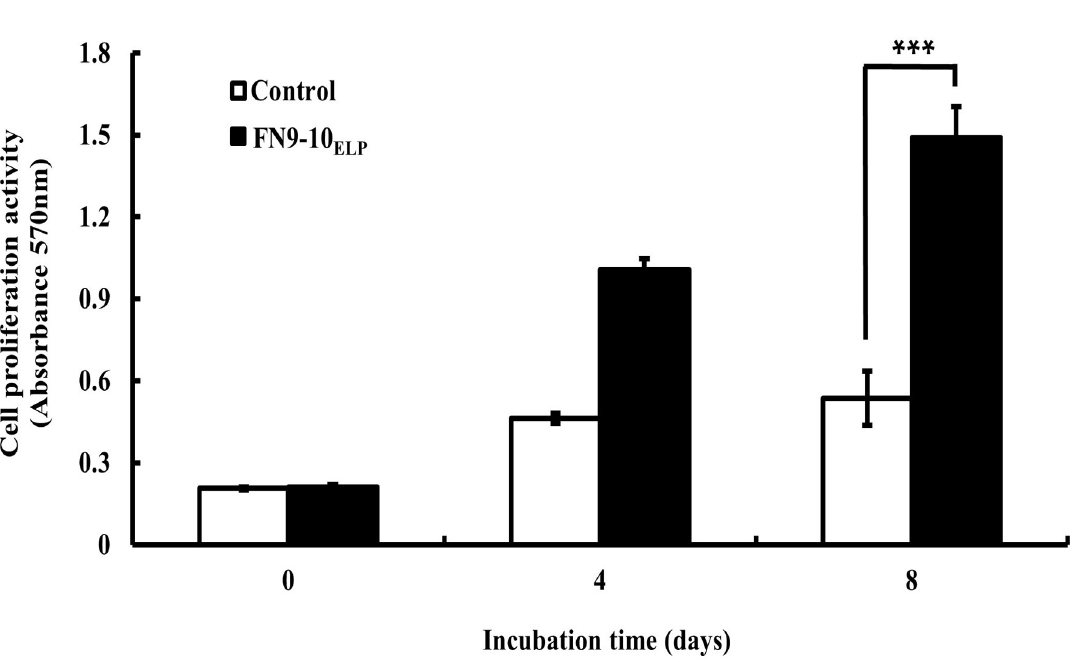
Fig 5. Cell proliferation activity of hMSCs on the FN9-10 ELP -titanium discs for 0, 4 and 8 days. The titanium discs were immersed in 0 or 10 μ g � mL − 1 FN9-10 ELP overnight at 4˚C then, hMSCs were seeded at a density of 1 × 10 4 cells/disc on titanium discs and incubated for 0, 4 and 8 days at 37˚C. The absorbance of formazan contained in the cells was used as a measure of cell proliferation. The cell proliferation activities are expressed as the mean ± SD (n = 3). p < 0.001.